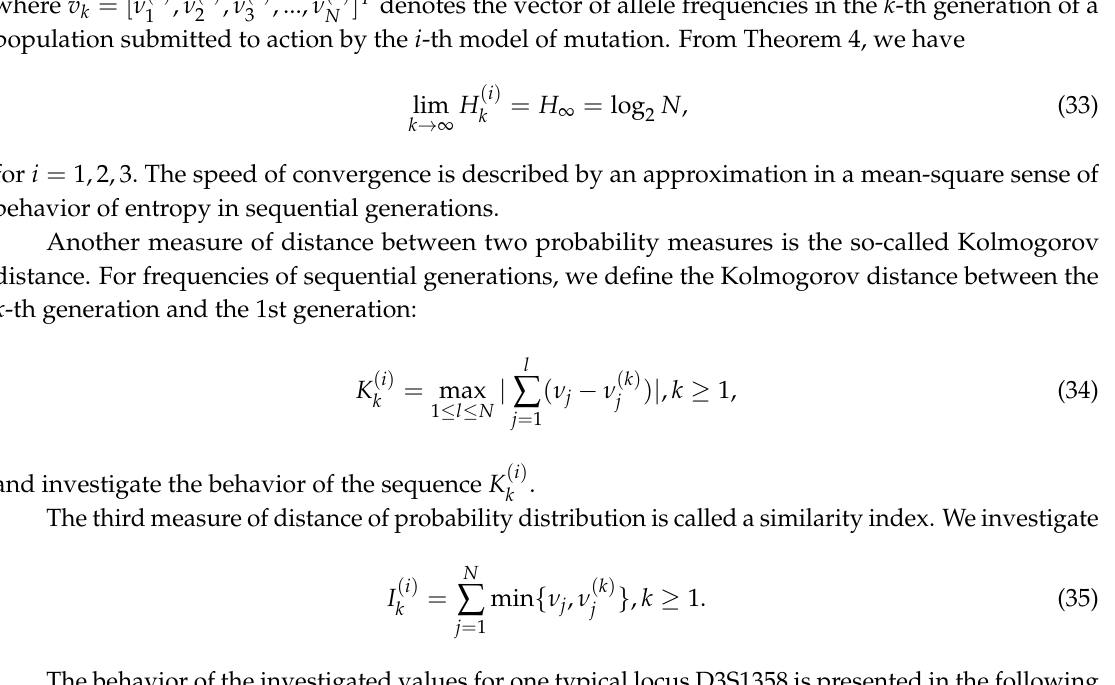
Figure 2. Investigated values: entropy H generation and k -th model, for locus